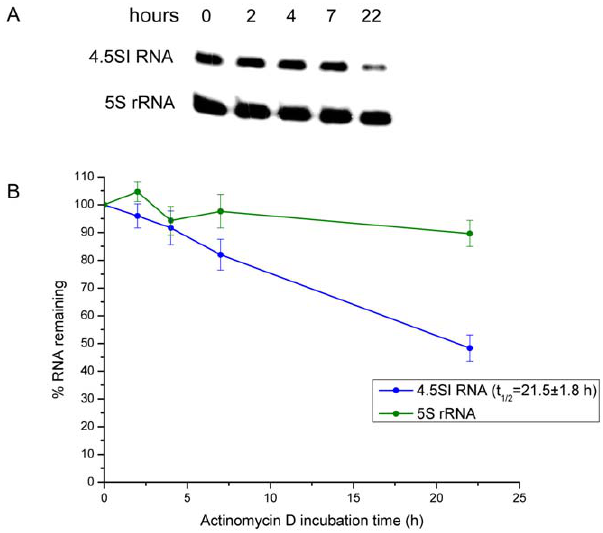
Figure 2. Determination of 4.5SI RNA half-life. ( A ) Northern hybridization of 4.5SI RNA and 5S rRNA in total RNA isolated from KAC cells exposed to actinomycin D for different time periods. ( B ) Graphs demonstrating the slow decrease of the 4.5SI RNA level in cells following the start of transcription inhibition. Highly stable 5S rRNA was used as a loading control. Error bars, s.d.,